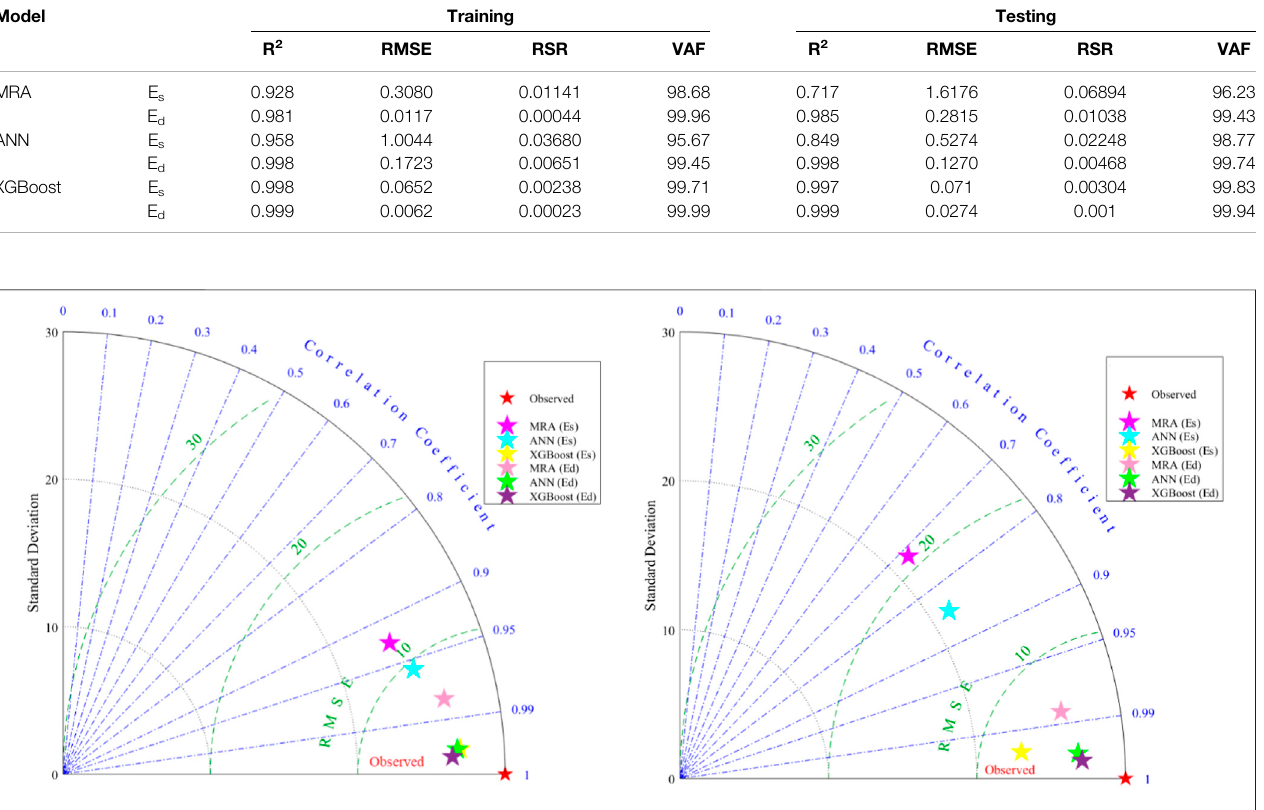
Frontiers in Earth Science |